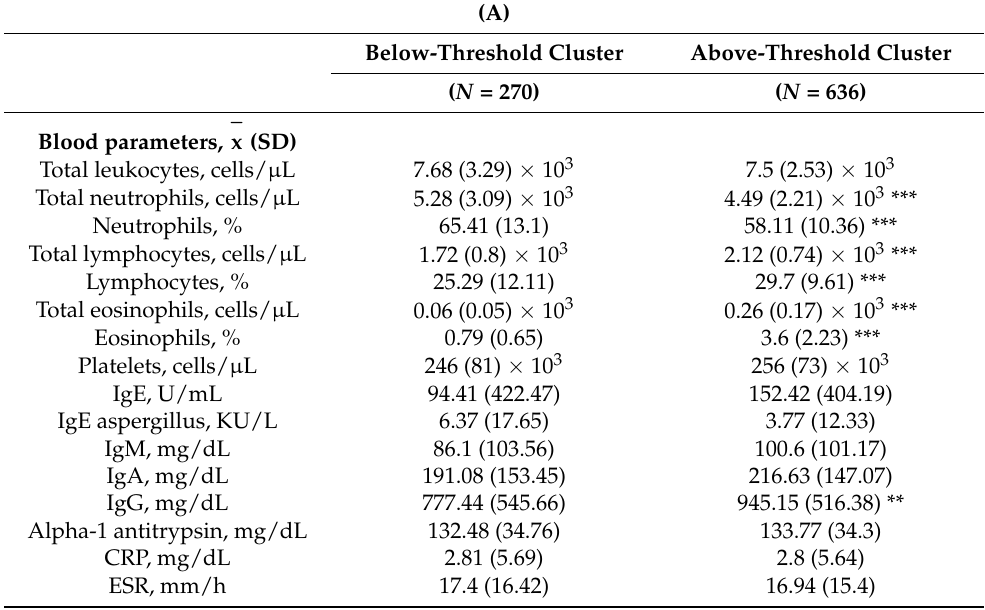
Table 2. ( A ) Inflammatory and nutritional parameters in the two clusters of patients. ( B ) The inflammatory and nutritional parameters in the two clusters of bronchiectasis patients, excluding those with